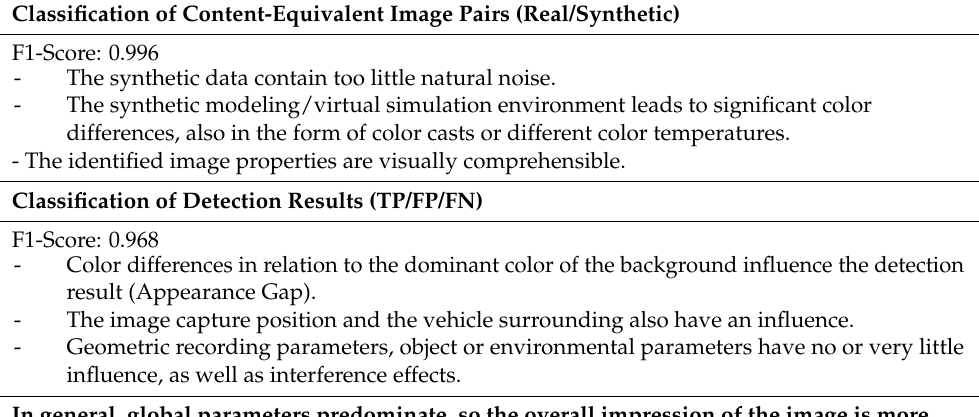
Table 4. Results of the statistical evaluation procedure based on a classification chain.